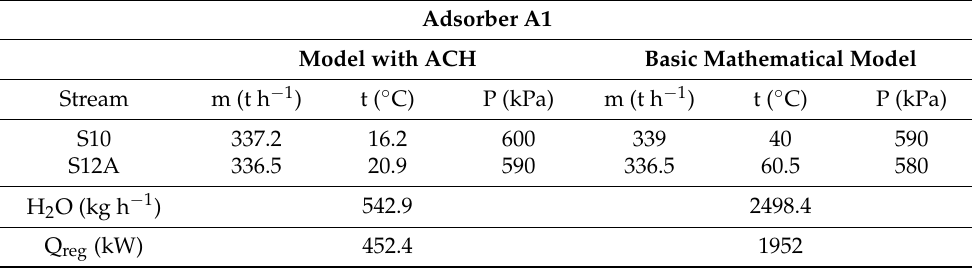
Table 9. Comparison of key parameters related to adsorber A1 obtained by basic ASU model and by model comprising ACH. Q reg : power input for adsorber regeneration.